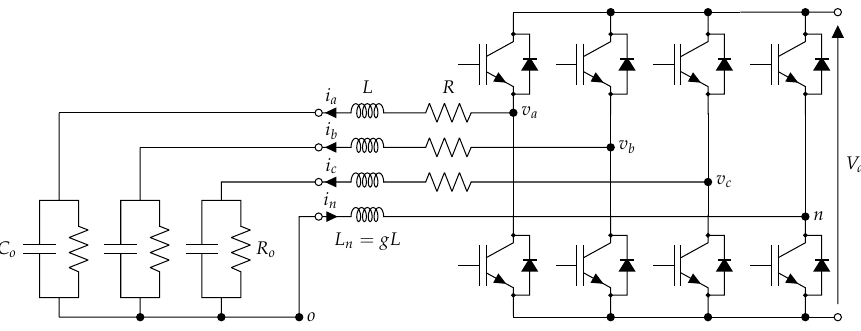
Figure 8. Three-phase, four-wire, four-leg inverter with a parametric neutral inductor. The experimental setup is iterated three times considering L n = L /2, L n = L , and L n = 2 L . Neutral inductor values are obtained by series/parallel combinations of inductors 246